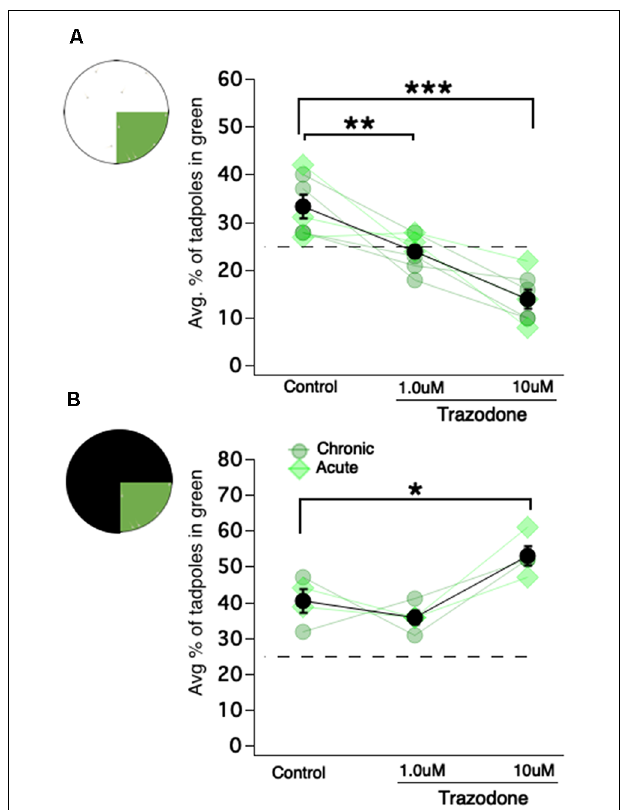
FIGURE 4 | Exposing Xenopus tadpoles to the selective serotonin reuptake inhibitor (SSRI) trazodone switches the preference for the green region of the dish to the brightest region of the dish, regardless of color. (A) A schematic of the green vs. white test and corresponding dot plot showing the average percentage of tadpoles in the green region as a function of trazodone concentration (** p < 0.01, *** p < 0.001). Each connected set of symbols represents the average values for a given clutch. The overall average (shown in black) represents the data obtained from seven different clutches of tadpoles. Acute exposure to trazodone (light green diamonds) and chronic exposure (gray-ish green circles) appeared to elicit the same effect. (B) Four of the seven clutches tested in the green vs. white test (shown in panel A ) were also tested in the green vs. black test (* p < 0.05). These data are also displayed as a dot plot showing the average percentage of tadpoles in the green region as a function of trazodone